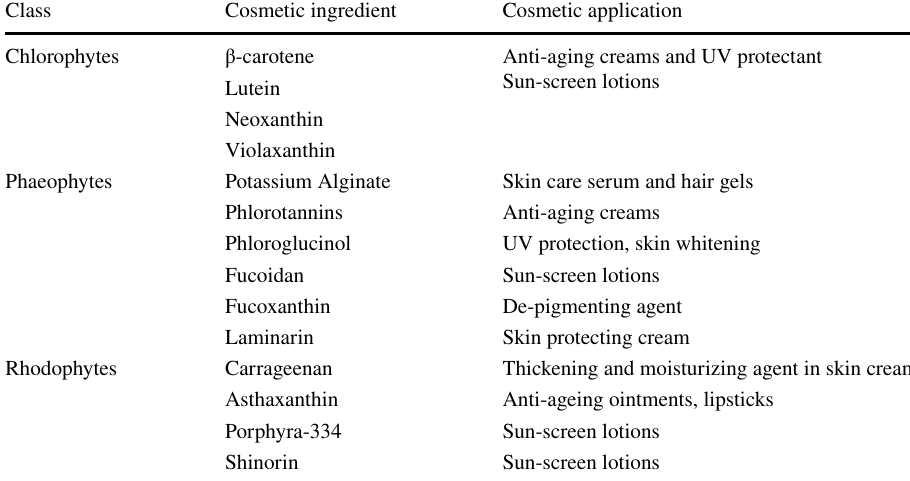
Table 2 Chief cosmetic ingredients from